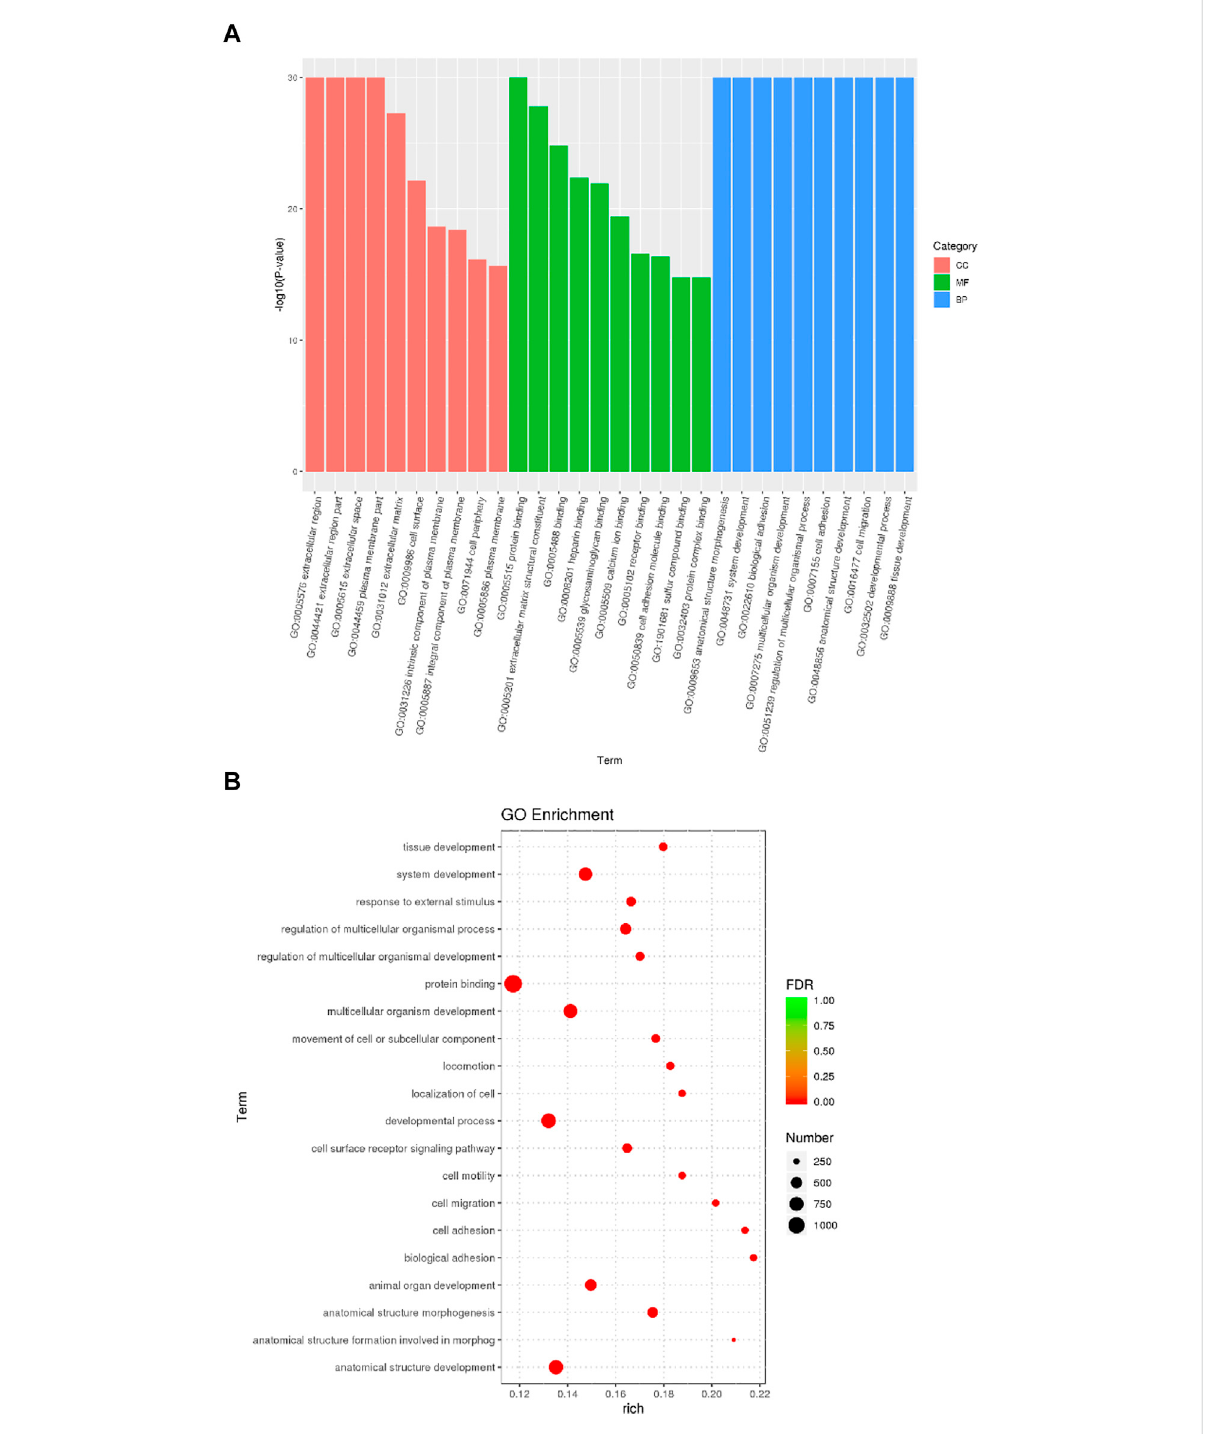
FIGURE 4 GO enrichment analysis of DEGs from BMSCs in high glucose microenvironment at 35 mM concentration for 30 days. (A) GO enrichment analysis histogram. (B) GO enrichment analysis bubble